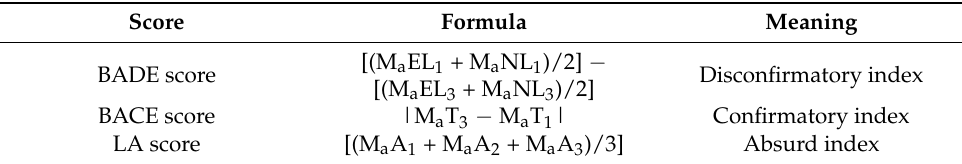
Table 2. The computation of the dependent variables of the BADE